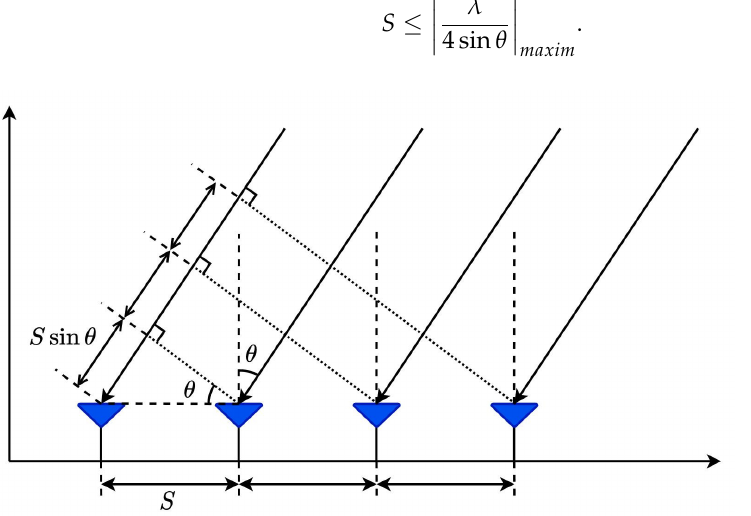
Figure 3. Spatial geometry of EPCs and electromagnetic wave incidence